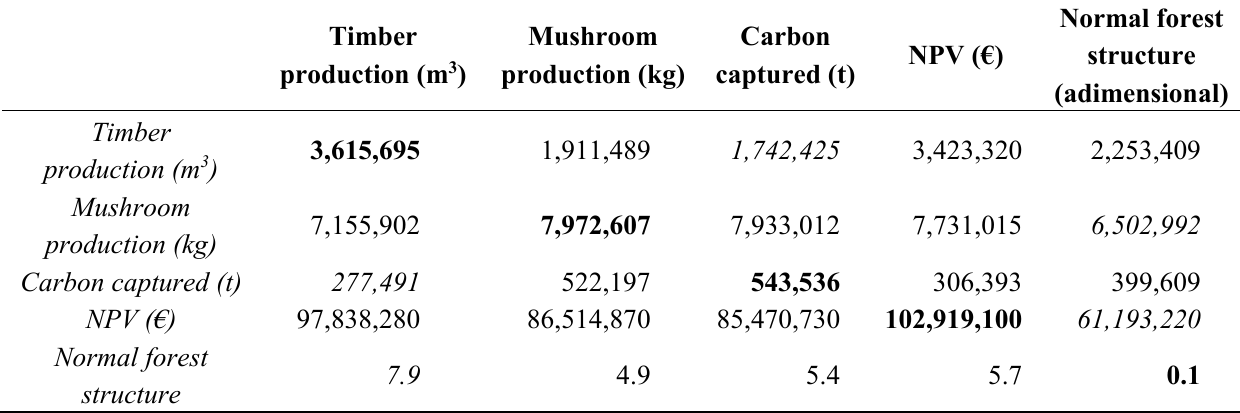
Table 1. Pay-off matrix under Scenario 1 (ideal values in bold; anti-ideal values in italics).